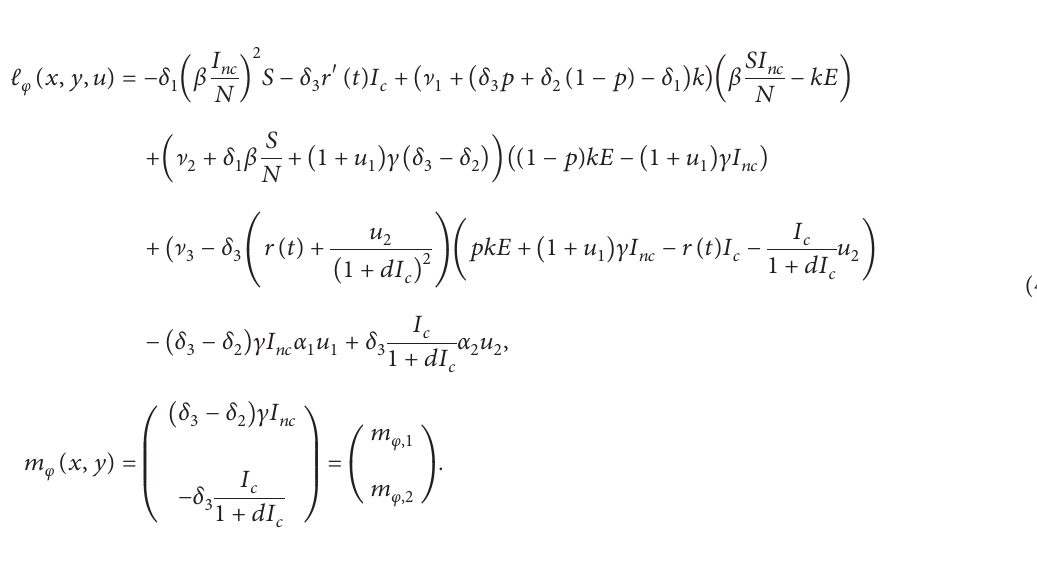
and u with δ � ] � ( 0 . 02 , 0 . 2 , 0 . 1 ) , 1 2